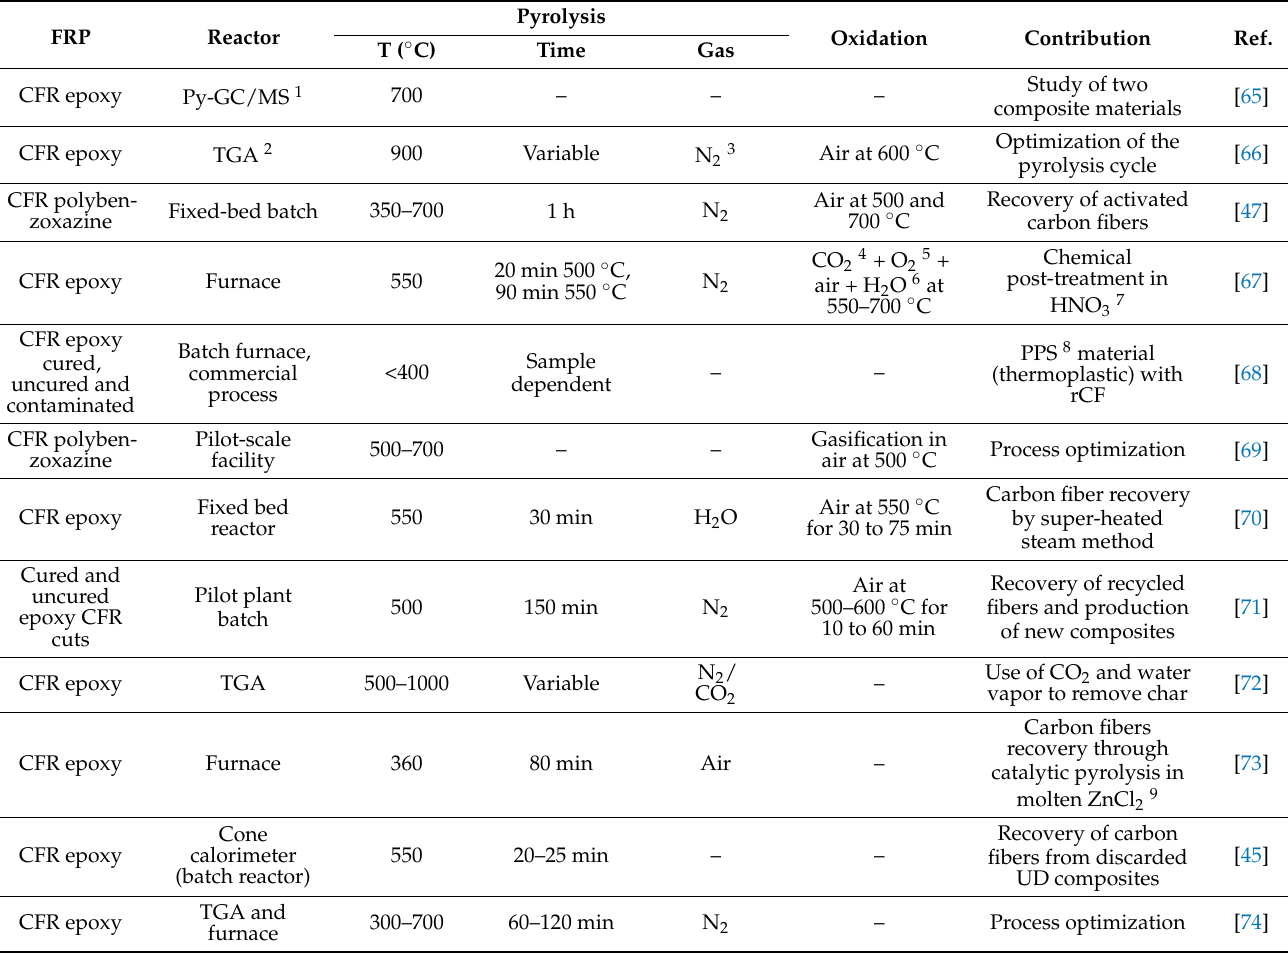
Table 2. Thermal recycling